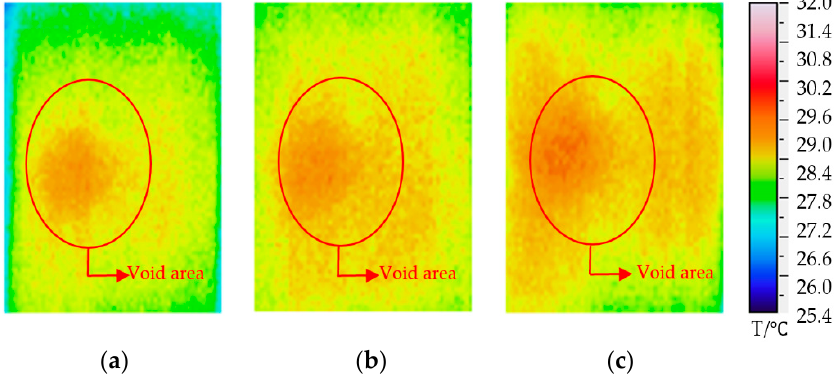
Figure 5. Infrared thermographs of group C: ( a ) t = 546 s; ( b ) t = 630 s; ( c ) t = 801 s.